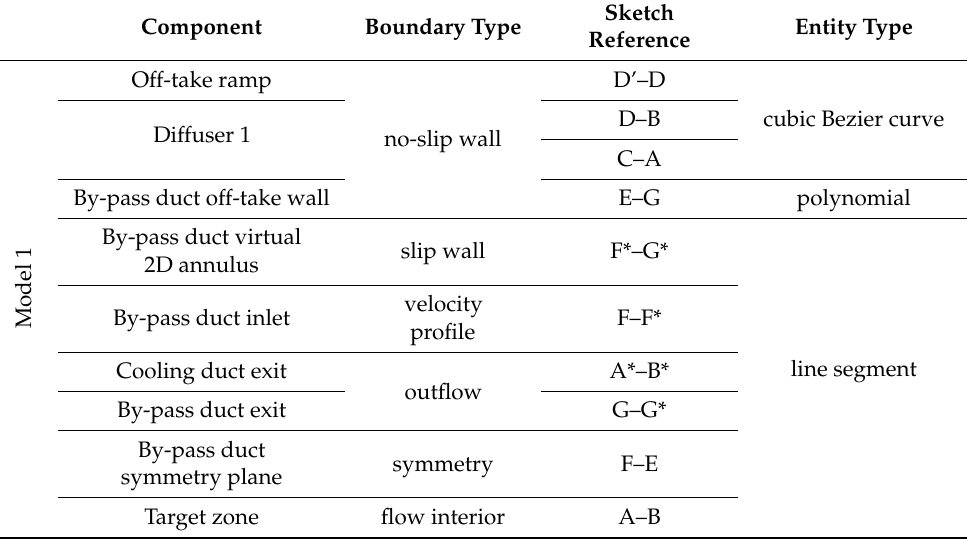
Table 1. Model 1 and model setup